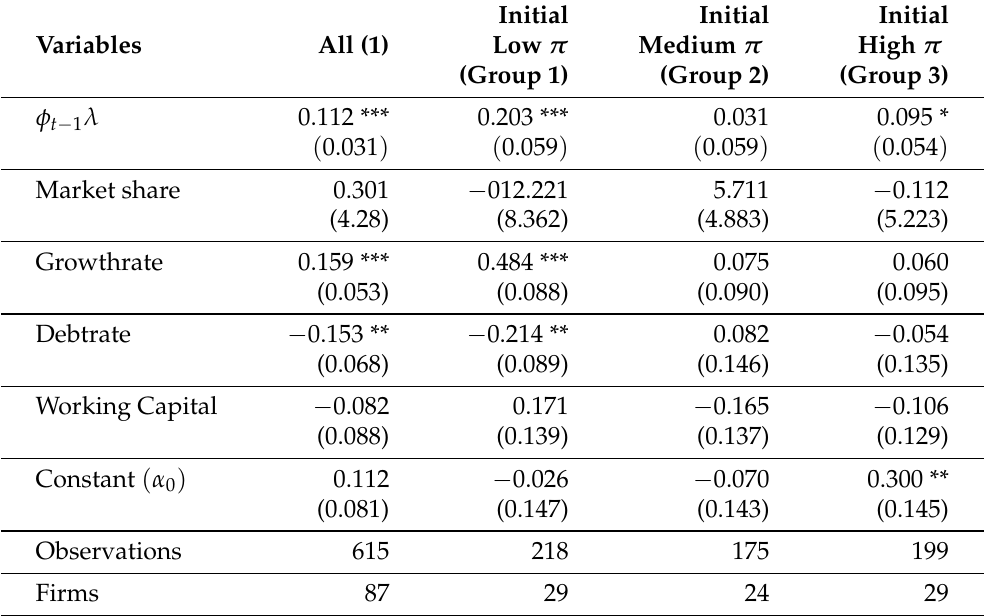
Table 5. Result from Model 3a (without salary as explanatory